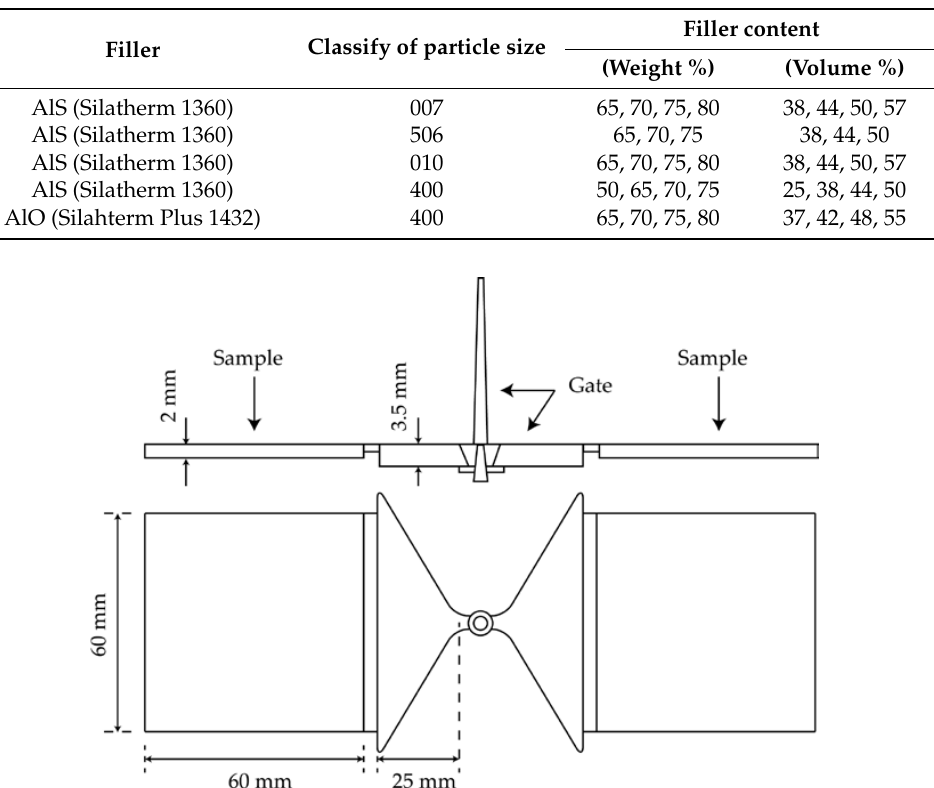
Figure 2. Geometry of injection molded samples.